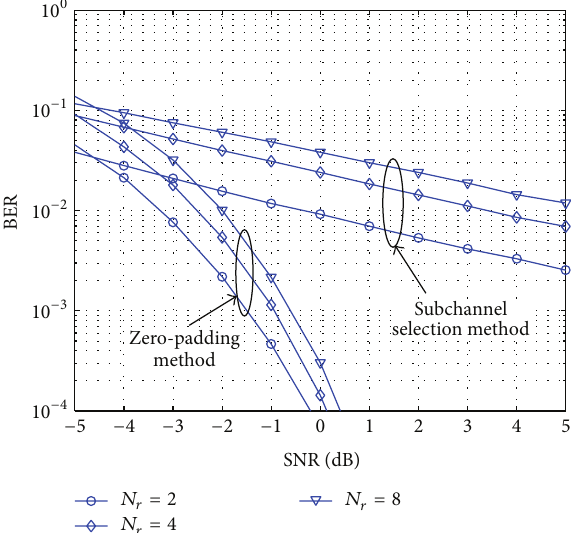
Figure 3: BER performance of subchannel selection method with different number of receiving antennas for 𝑁 𝑡 = 10 , 𝐾 = 2 , and 𝐾 = 4 for QPSK modulation.